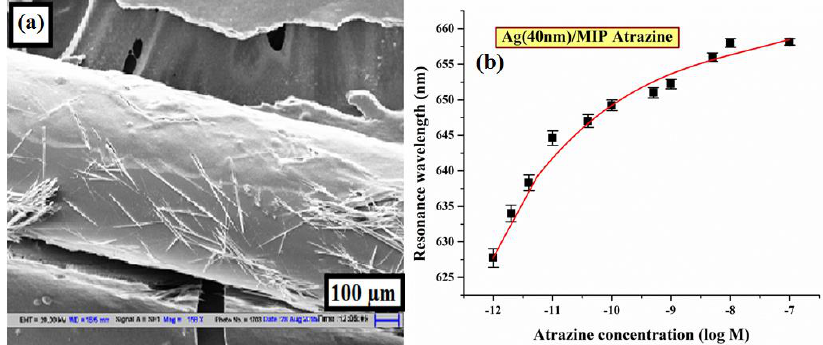
Figure 16. ( a ) SEM micrograph of a MIP-based atrazine sensor showing polymer coated over fiber probe and ( b ) the calibration curve of the sensor for 10 −12 –10 −7 M of aqueous atrazine samples. Reprinted with permission from [47]. Copyright 2016 Elsevier.